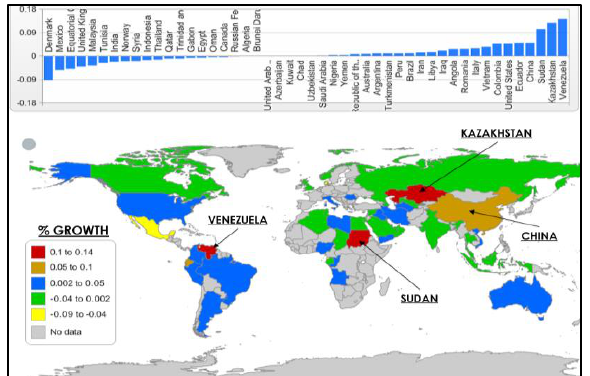
Figure 5. Percentage growth in crude-oil reserves from 2005 to 2015.